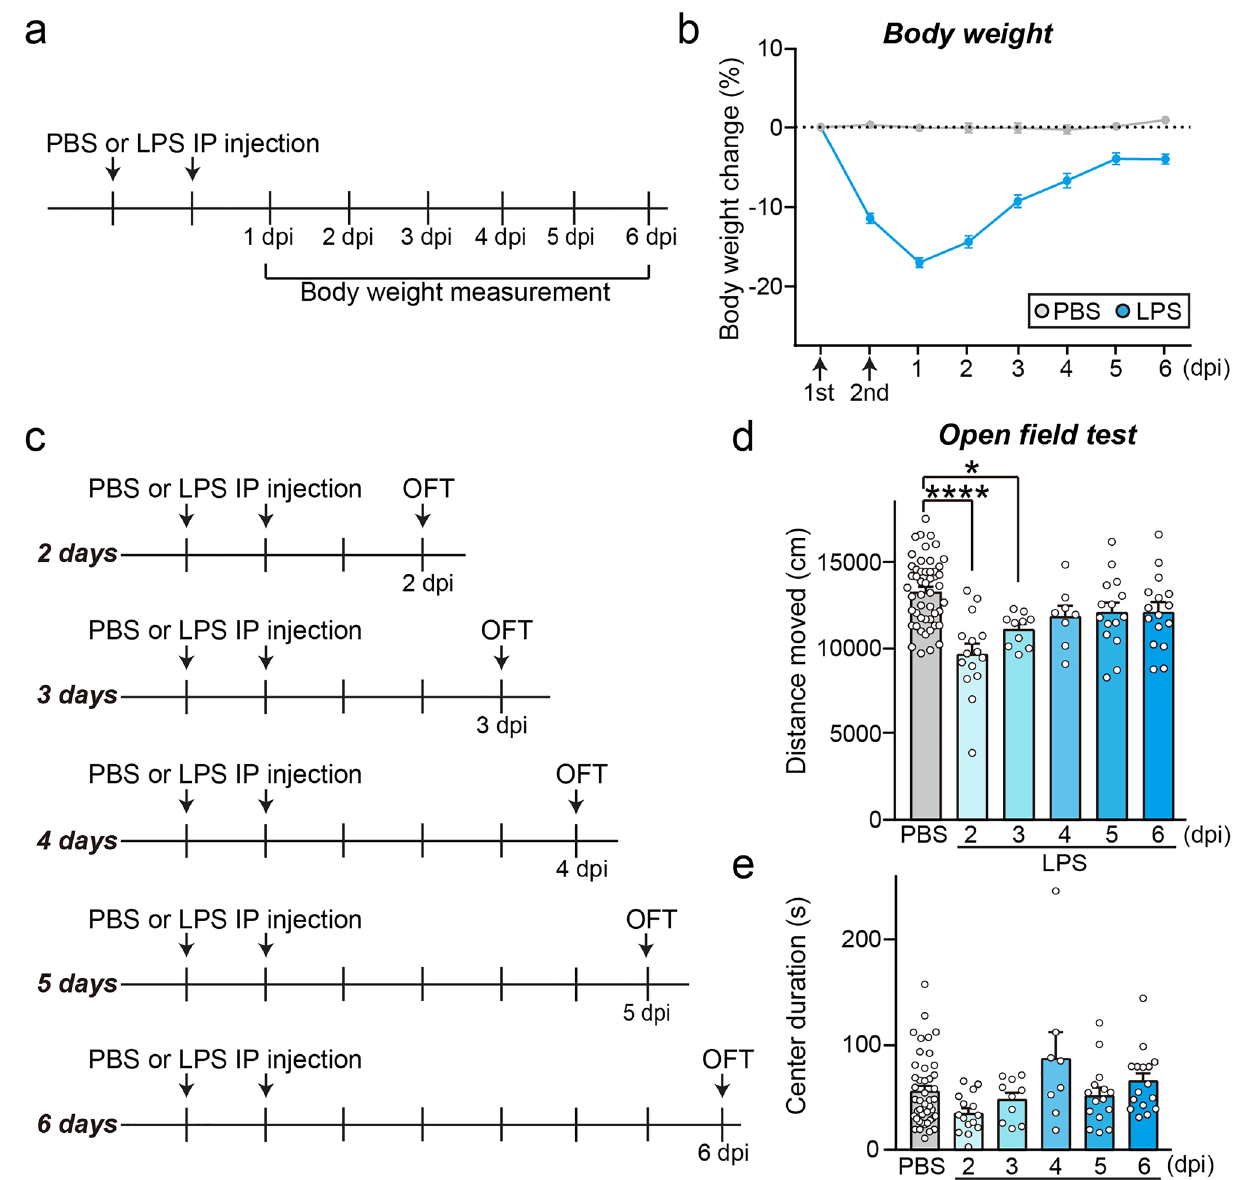
Figure 1. Behavioral signs of sickness under systemic inflammation are alleviated by day 4 after LPS injection in mice. ( a ) Schematic illustration of the experimental procedure for performing LPS injection and daily body- weight measurement of mice. ( b ) The LPS-injected mice initially displayed a body weight reduction of about 20% body at 1 dpi, and body width recovered to 90% by day 4 after LPS injection. Each measured body weight was normalized by that obtained before the first injection. The level of 1 is marked by a dotted line (PBS, N = 14; LPS N = 22). ( c ) Schematic illustration showing the procedures used for LPS administration and the open-field test (OFT). ( d , e ) Quantification of the distance moved ( d ) and center duration ( e in OFT conducted 2–6 days after injection of LPS or PBS (**** P < 0.0001, * P < 0.05; PBS, N = 50; LPS, N = 8–16; one-way ANOVA with post- hoc Dunnett’s